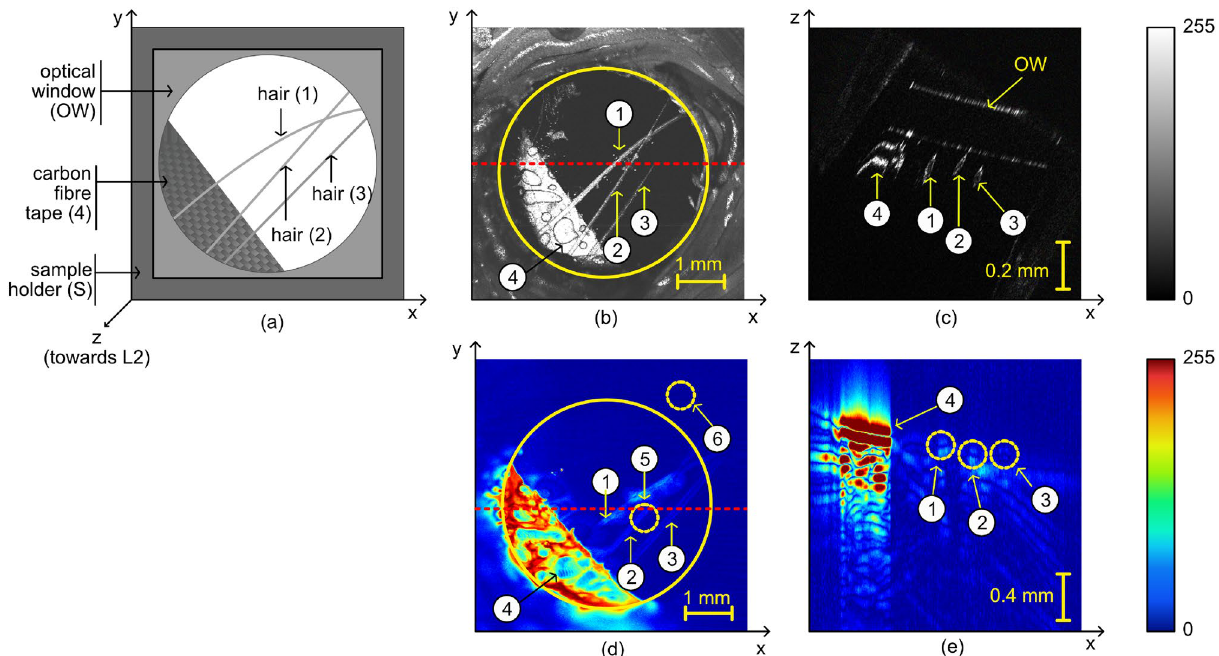
Figure 3. ( a ) Schematic diagram of the sample designed to produce images of the human hair: 1, 2, 3 are the three imaged hairs, placed on an optical window (OW); the ends of the hairs are covered by a carbon fibre tape (4); incident light from OS1 and OS2 travels towards the sample in the z -direction. ( b ) En face OCT image of the sample showing both the carbon fibre tape (4) and the three hairs. ( c ) Example of a B-scan OCT image showing the carbon fibre tape, the hairs as well as the optical window. The hairs look elongated as they are not placed orthogonal to the xz -plane. ( d ) En face PAM image showing the carbon fibre tape and the hairs. Regions 5 and 6 are used to calculate the signal-to-noise ratio using the procedure described within the manuscript. ( e ) Example of a B-scan PAM image. The optical window is not visible in the PAM image. The red horizontal dashed lines shown on the en face images indicate the y-position where the B-scans are originating